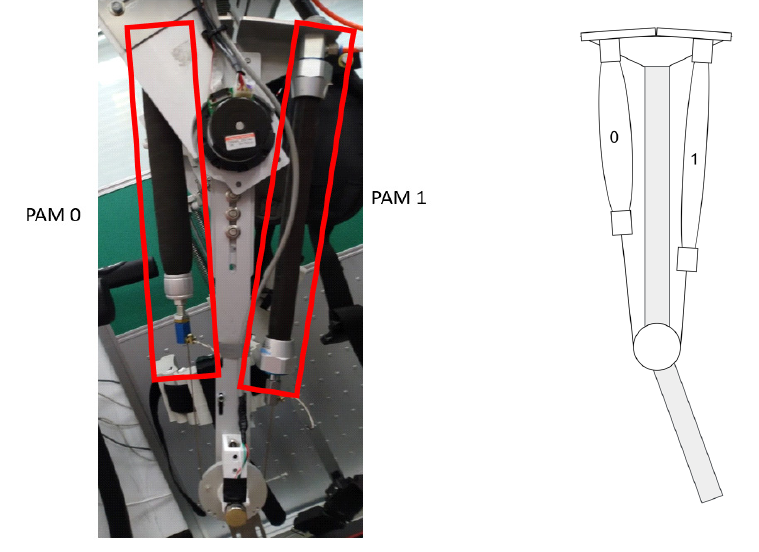
Figure 5. Knee joint mechanism.